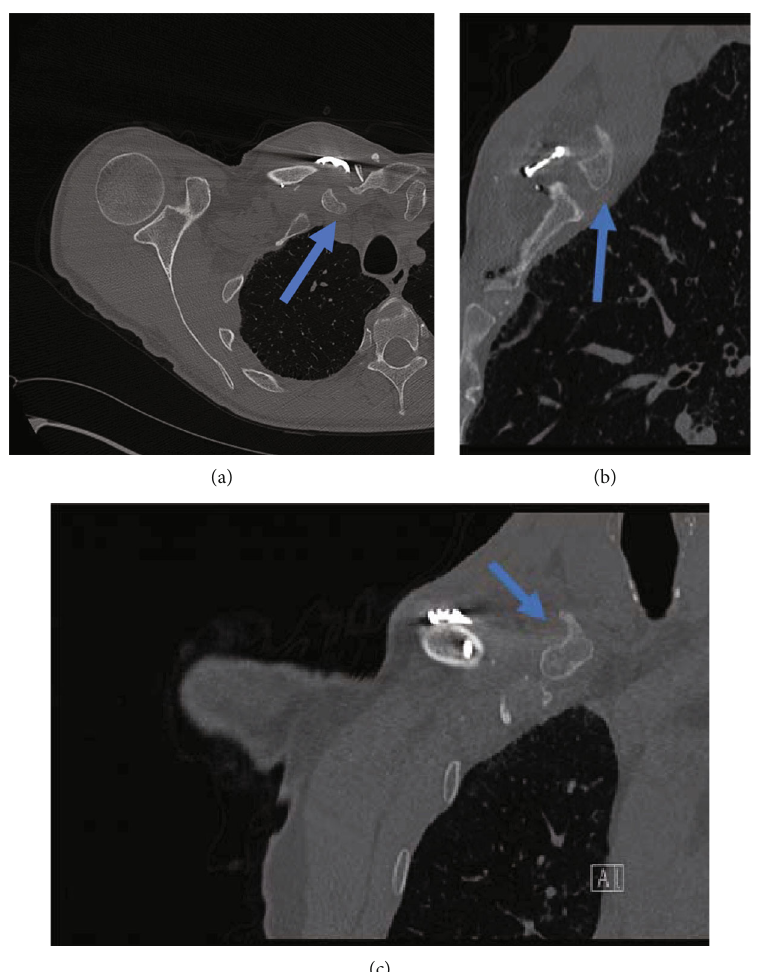
Figure 5: Five months post-ORIF. CT images showing hardware migration and posterior displacement of the remaining medial end of the right clavicle (blue arrow) (a – c).